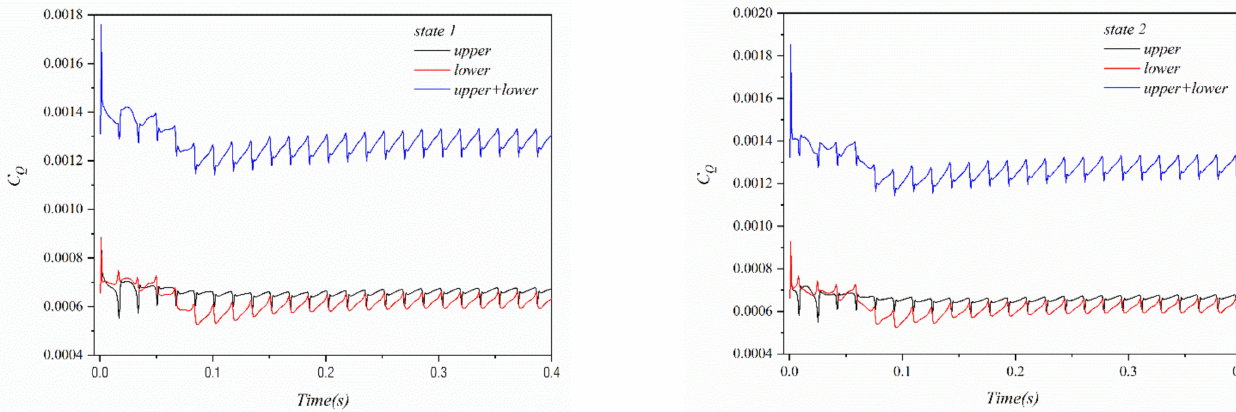
Figure 10. The isolated rotor C T of the upper and lower rotors in hover.